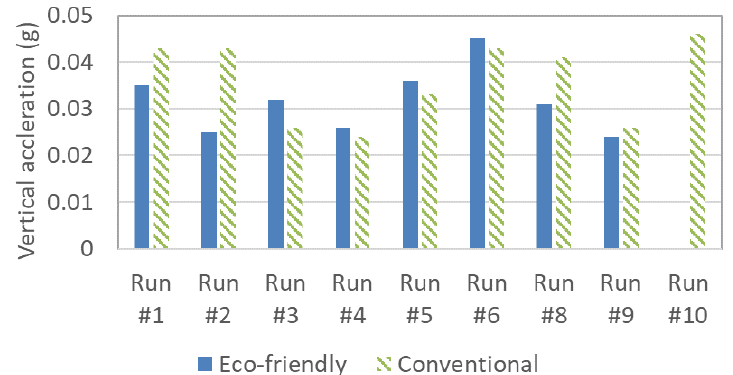
Figure 16. Vertical accelerations on the B2S panels.